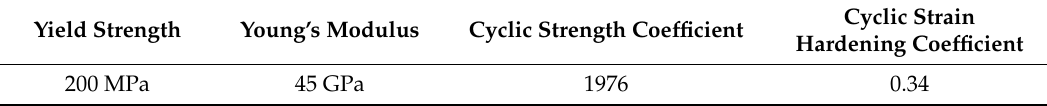
Table 5. Mechanical properties of extruded AZ31 magnesium alloy [31].